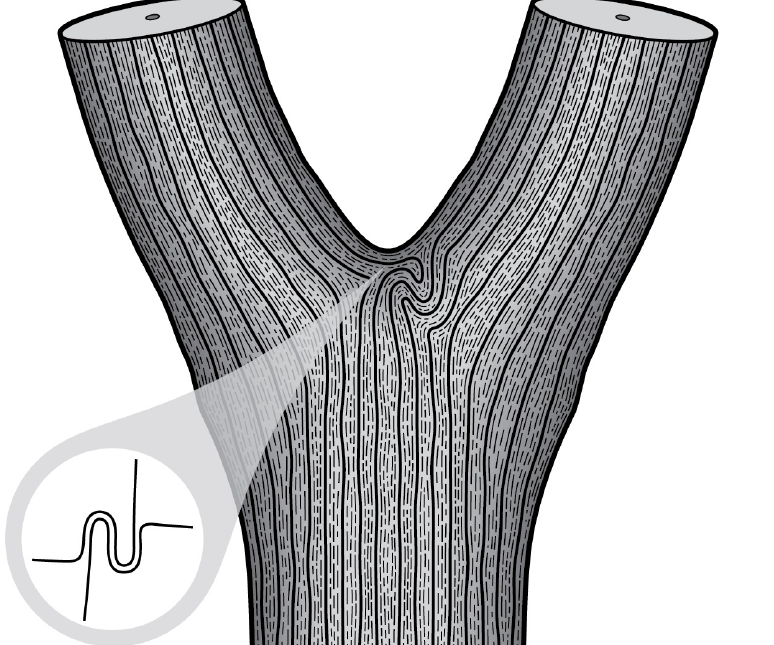
Figure 2. The structure of a fork junction (Slater & Ennos 2016: fig. 1). At the top of the junction the grain is interlocked, strengthening the joint and preventing the branch being pulled off. A similar arrangement is seen in branch junctions with smaller branches emerging from thicker